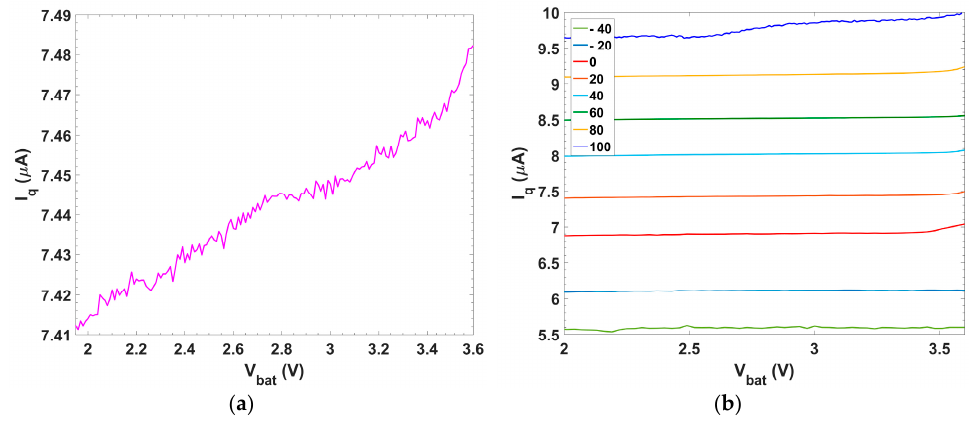
Figure 9. Quiescent current at: ( a ) room temperature; and ( b ) over different temperatures. The Line Regulation (LNR) is the static variation at the output voltage Δ V out due to a static